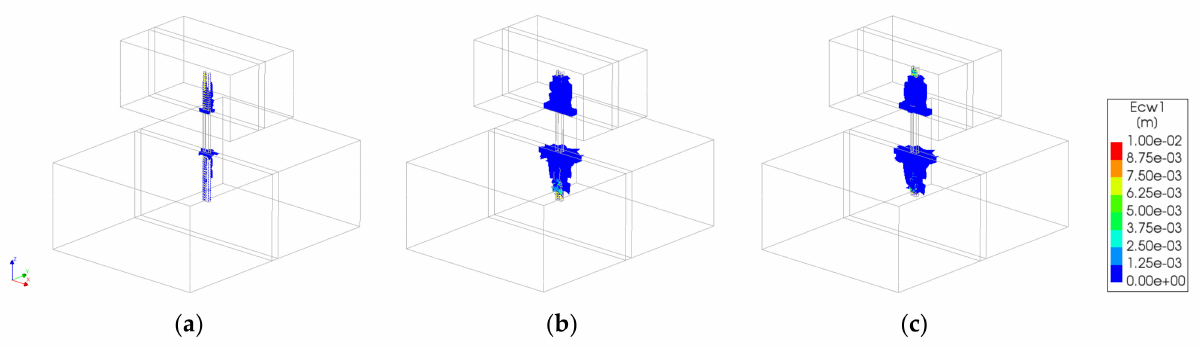
Figure 13. Damage evolution during the analysis of the complete assemblage in compression (crack width in m). ( a ) d = 1 mm; ( b ) d = 5 mm; ( c ) d = 10 mm.